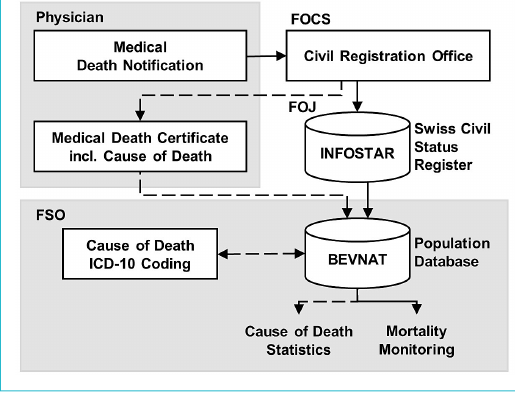
Figure 1: Administrative and informational paths leading from a death notification to the generation of weekly mortality updates and eventually to cause of death statistics. The Federal Office of Statistics' (FSO) BEVNAT database receives nightly updates through the Federal Office of Justice (FOJ) INFOSTAR register, al- lowing for timely mortality monitoring with weekly reports. Cause of death statistics require additional processing and coding, implying a longer publication